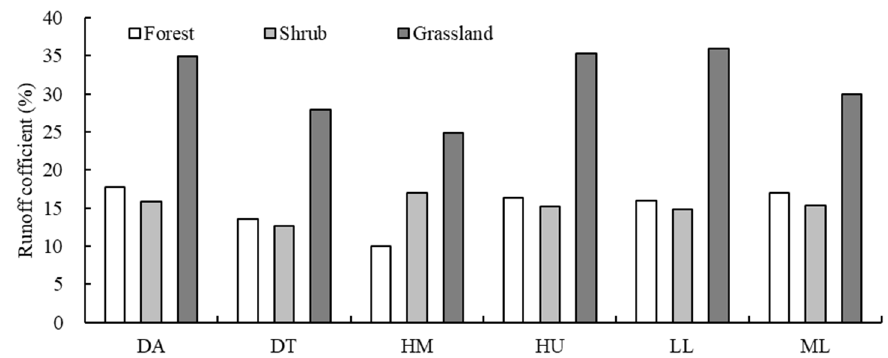
Figure 14. The runoff coefficient of different ecosystem types in Figure 14. The runo ff coe ffi cient of di ff erent ecosystem types in sub-watersheds.